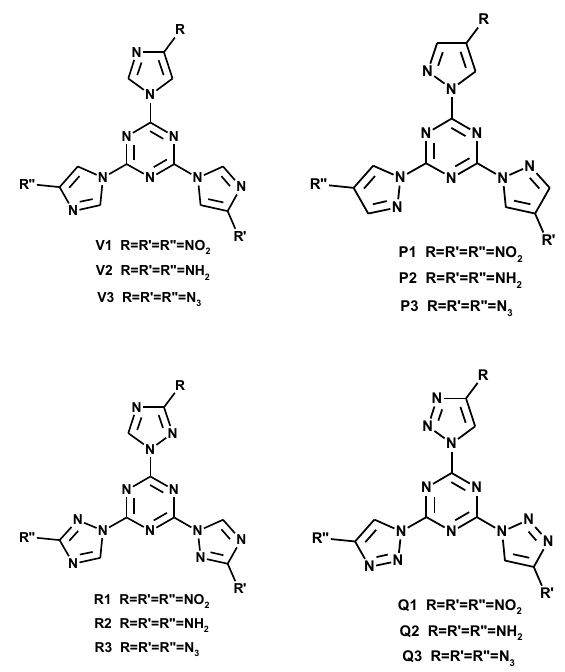
Figure 1. Chemical structures of the s -triazine derivatives